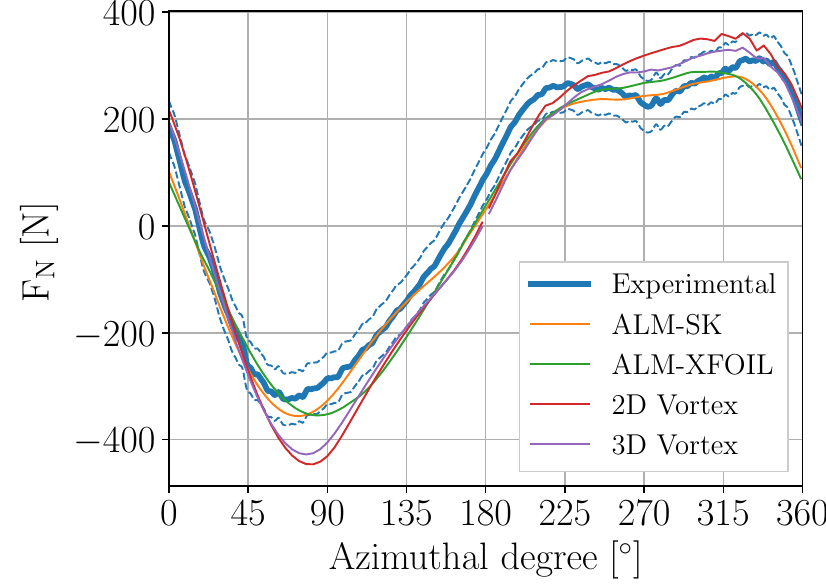
Figure 9. The normal force response at λ = 3.44.